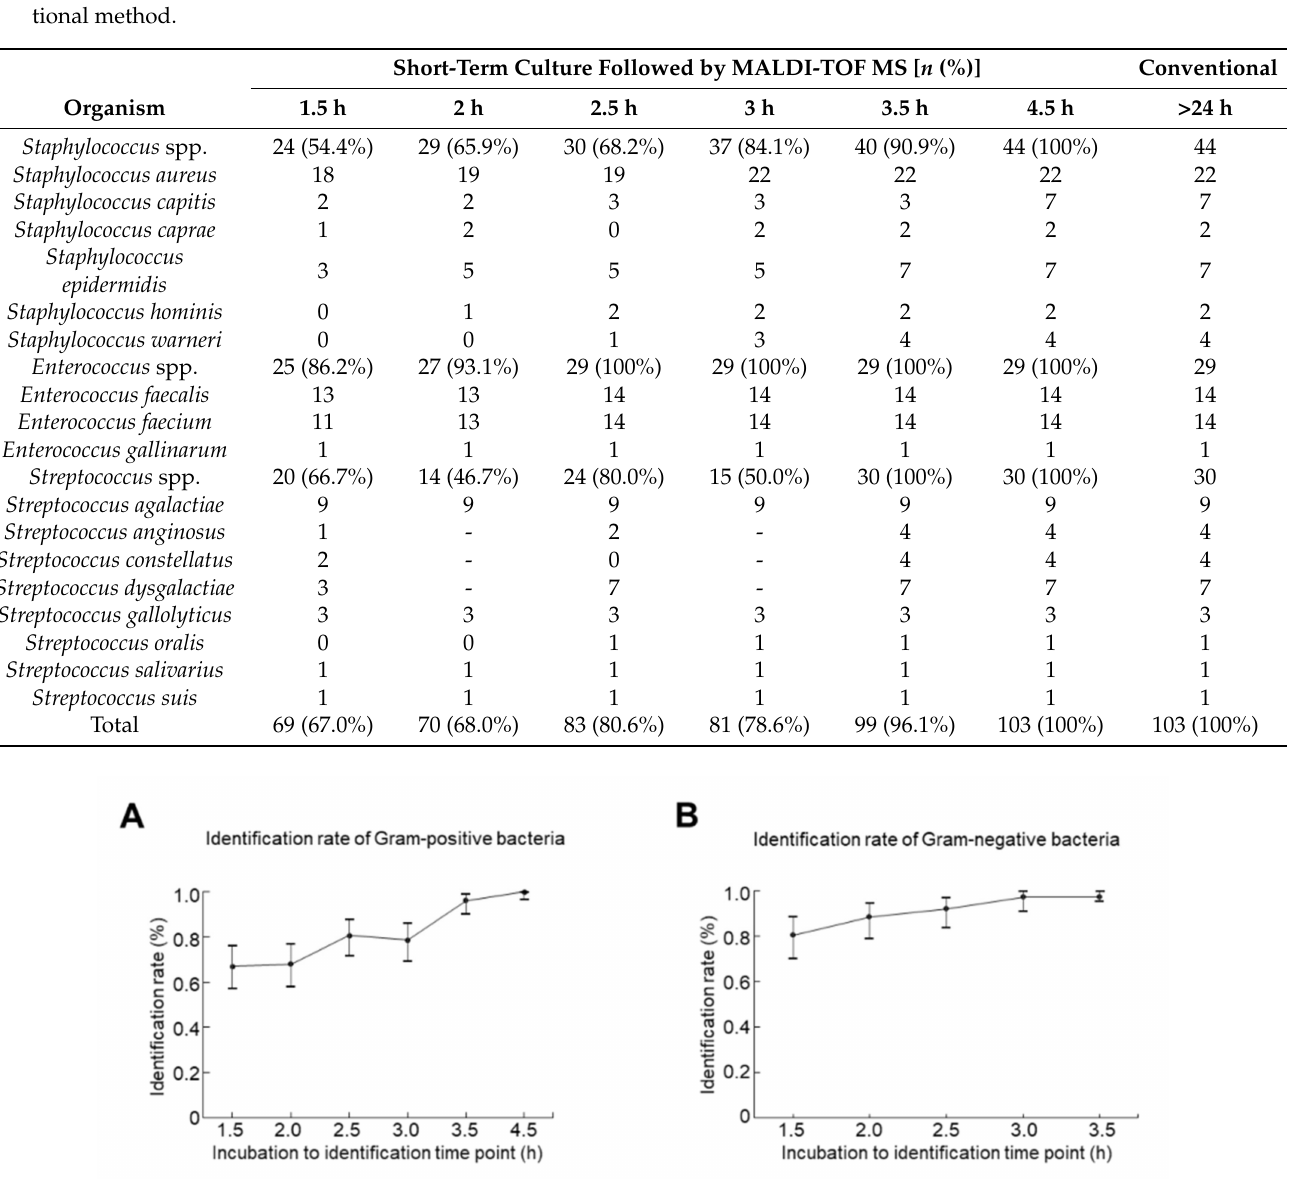
Figure 1. Identification rates (point estimations and 95% confidence intervals) for ( A ) Gram-positive and ( B ) Gram-negative bacteria at different incubation time